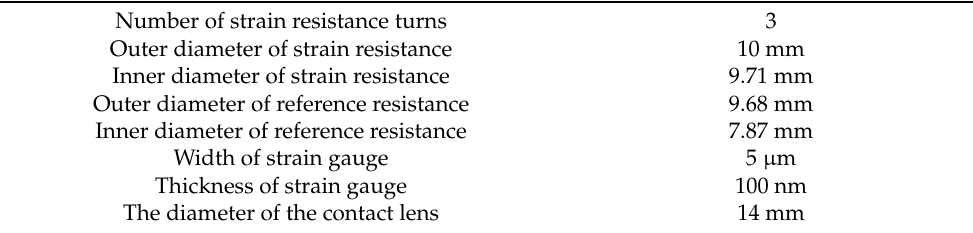
Table 1. Sensor design